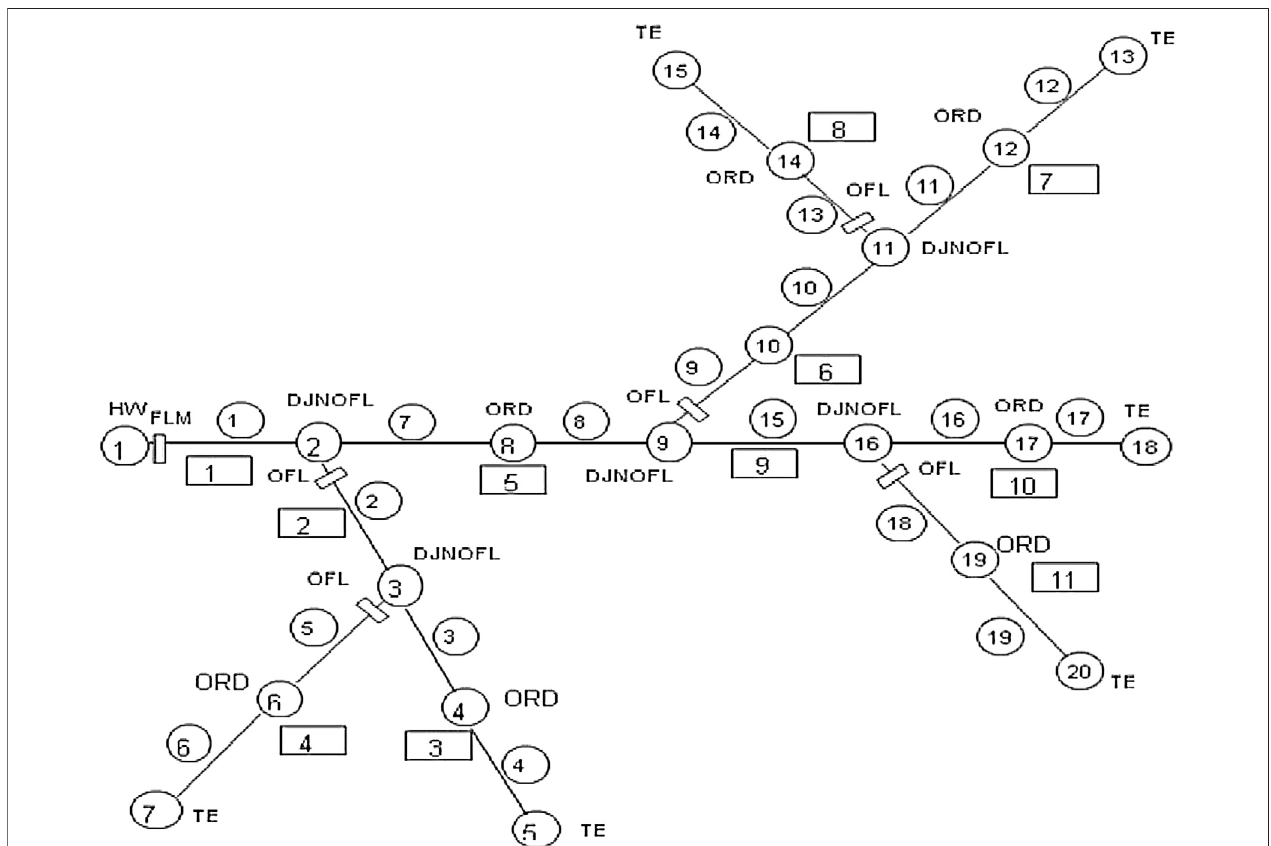
FIGURE 6 | Example network with open fl ume